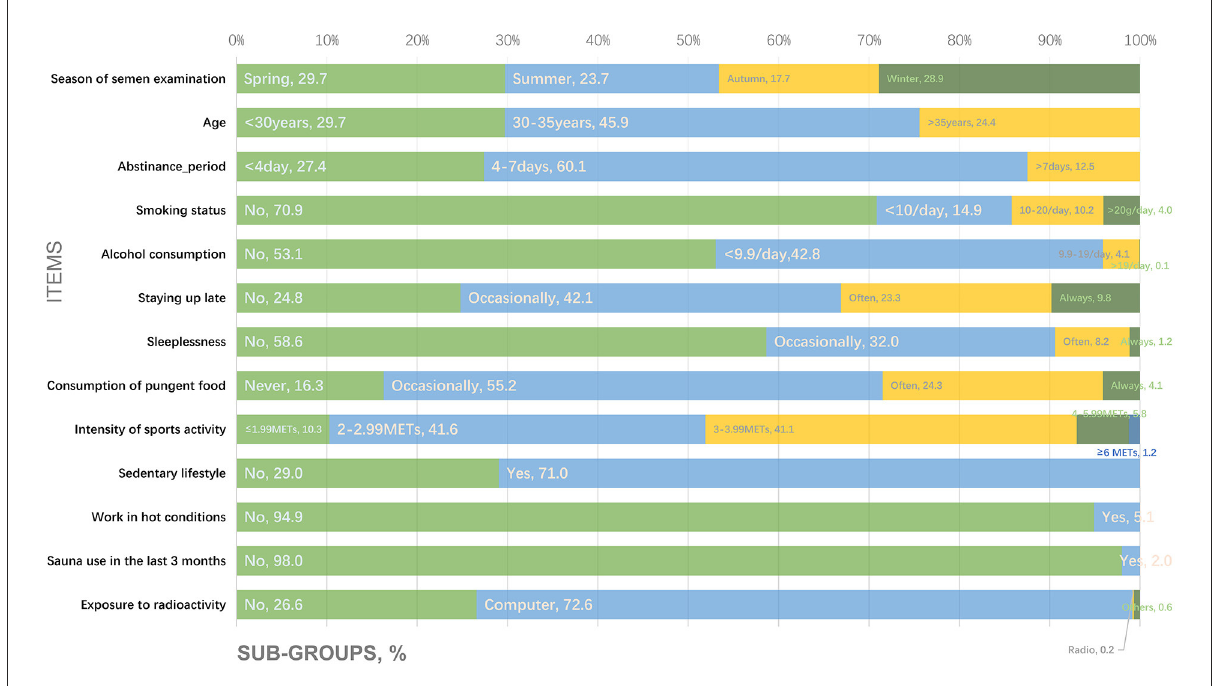
FIGURE2 Information regarding the general and lifestyle characteristics of study